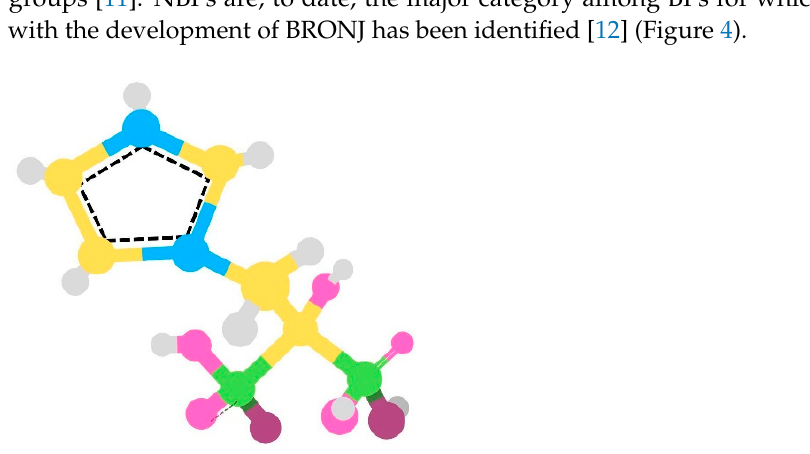
Figure 4. Chemical structure of the molecule of zoledronic acid (zoledronate).